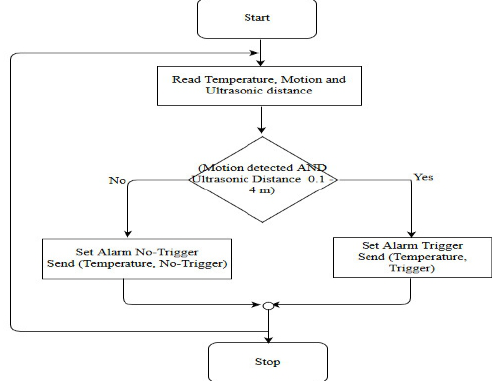
Fig. 6. Sensor node software logic